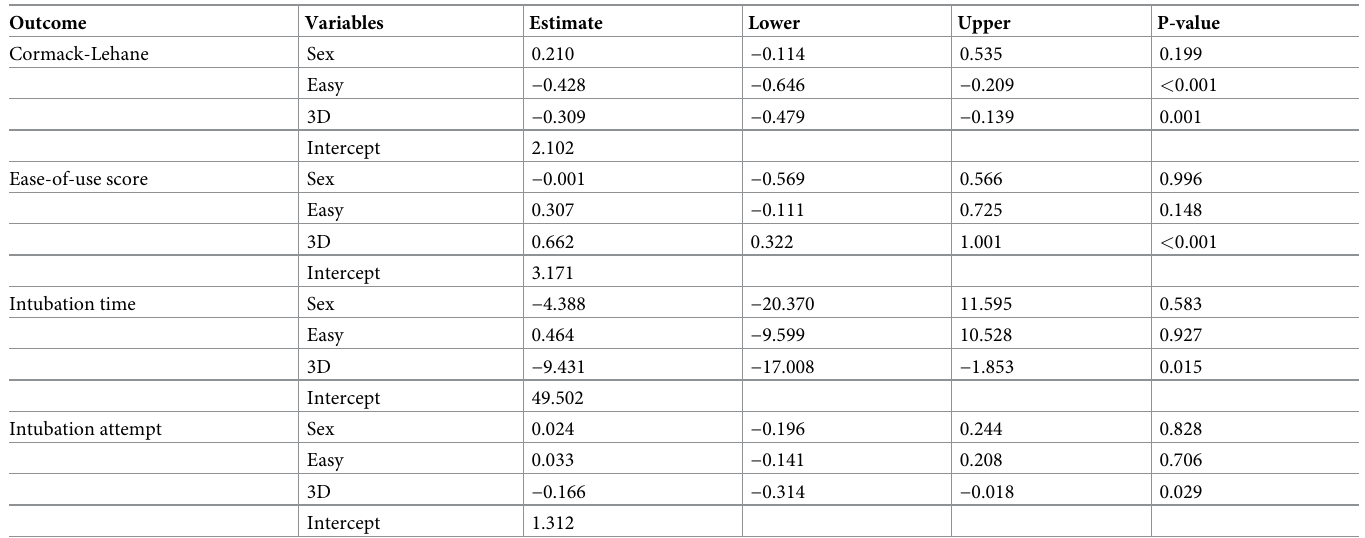
Table 2. Linear mixed model for predicting Cormack-Lehane grade, ease-of-use score, intubation time, and number of intubation attempts.